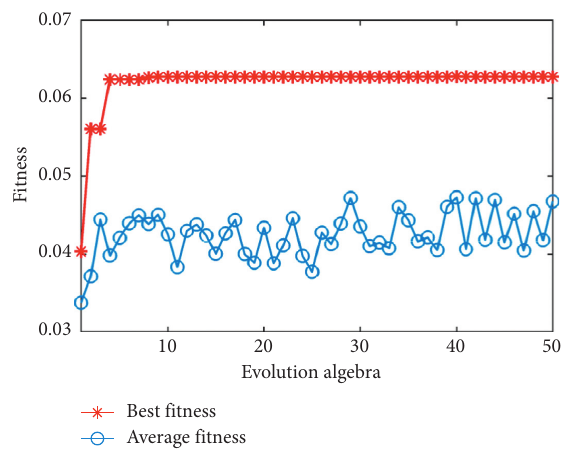
Figure 20: The trend of local energy ratio with evolution